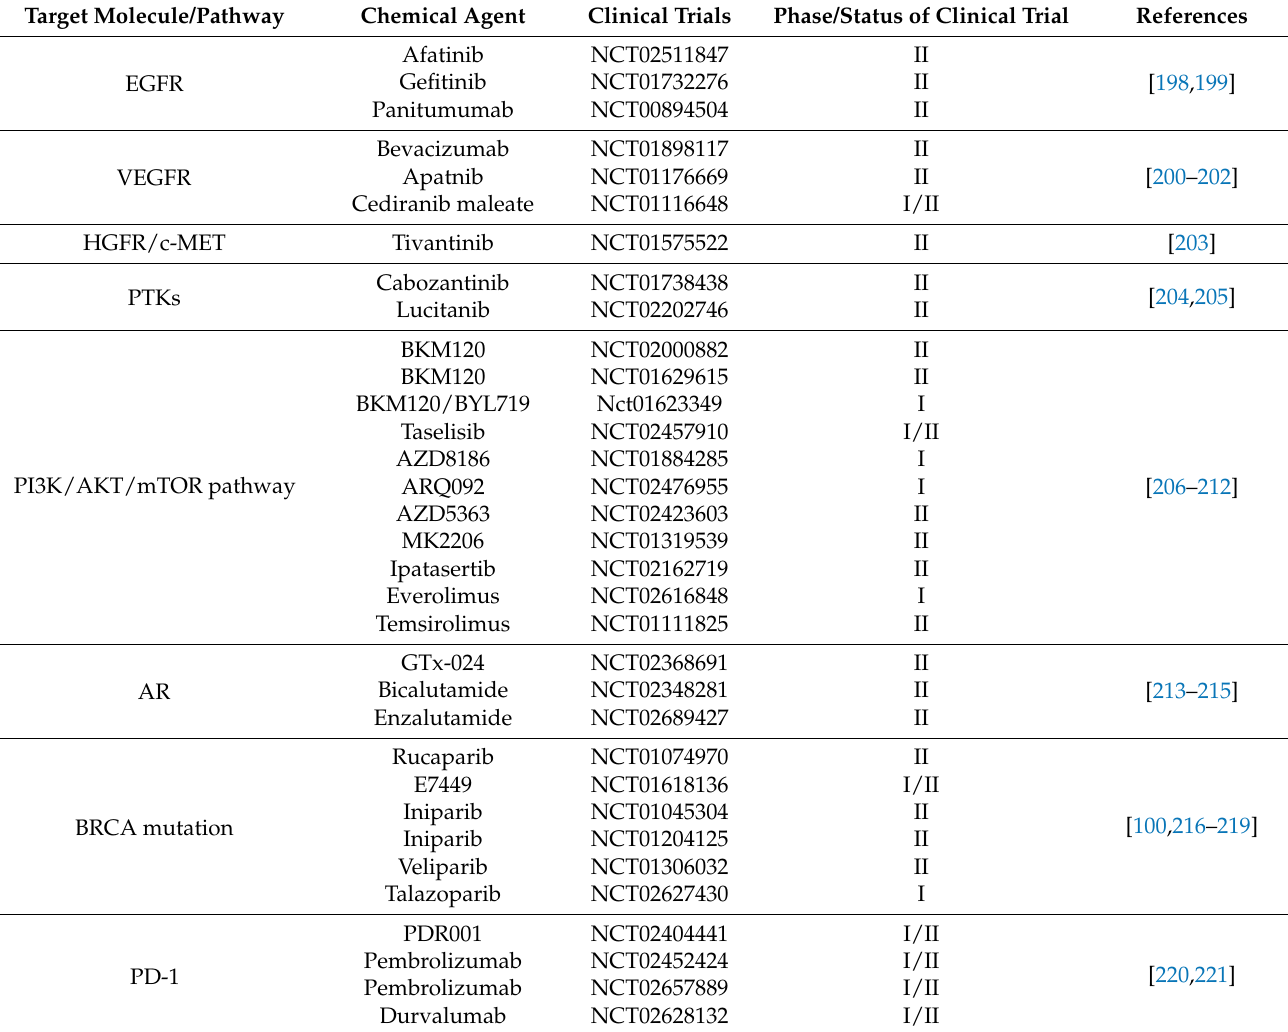
Table 3. Clinical trial status of potential targets of